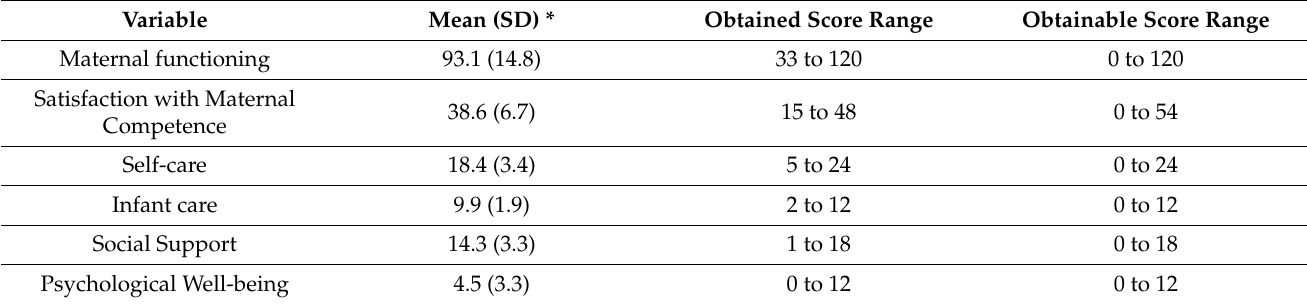
Table 2. The status of maternal functioning and subdomains ( n = 564).